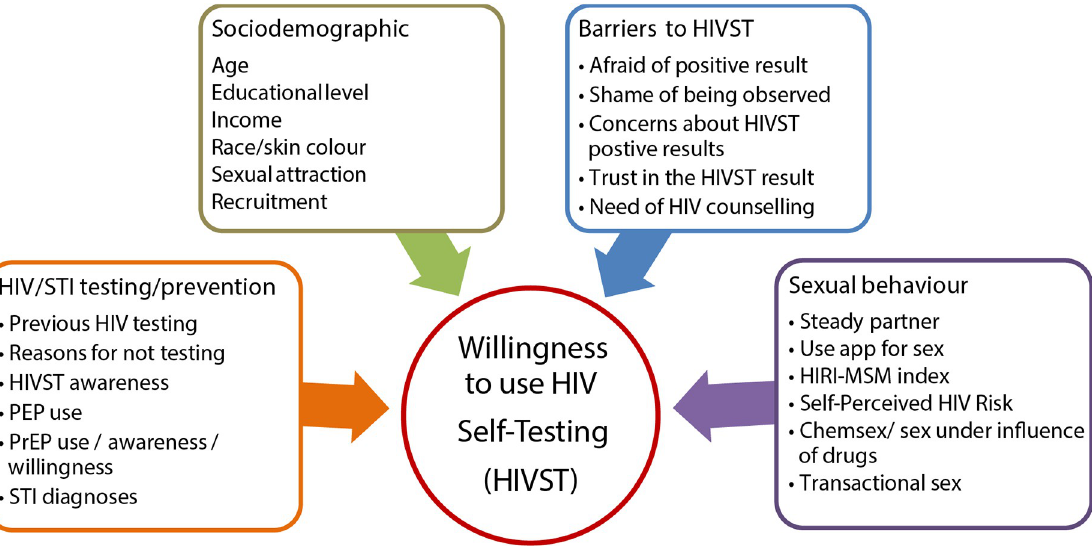
Fig 1. Potential factors associated with willingness to use